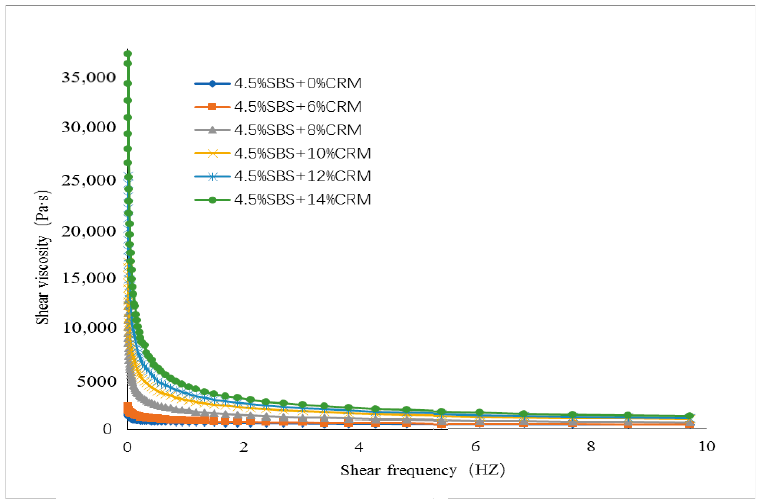
Figure 3. ZSV curves of Shuang long modified asphalt binder (fixed SBS and various CRM).